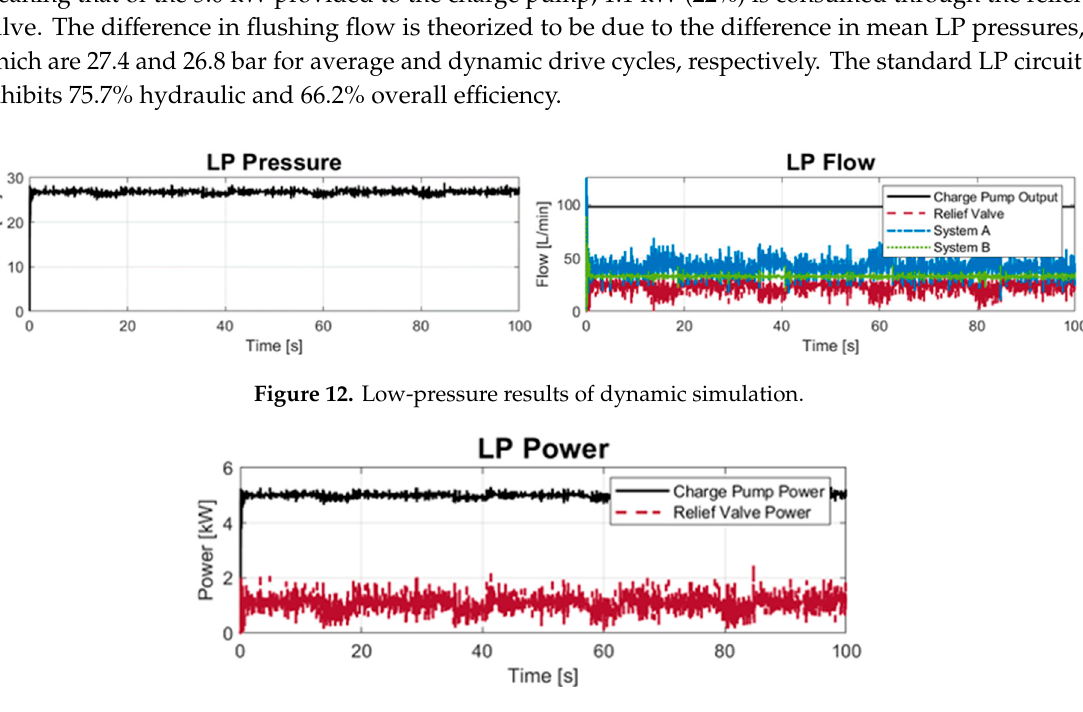
Figure 11. Reference system response to dynamic operating conditions.